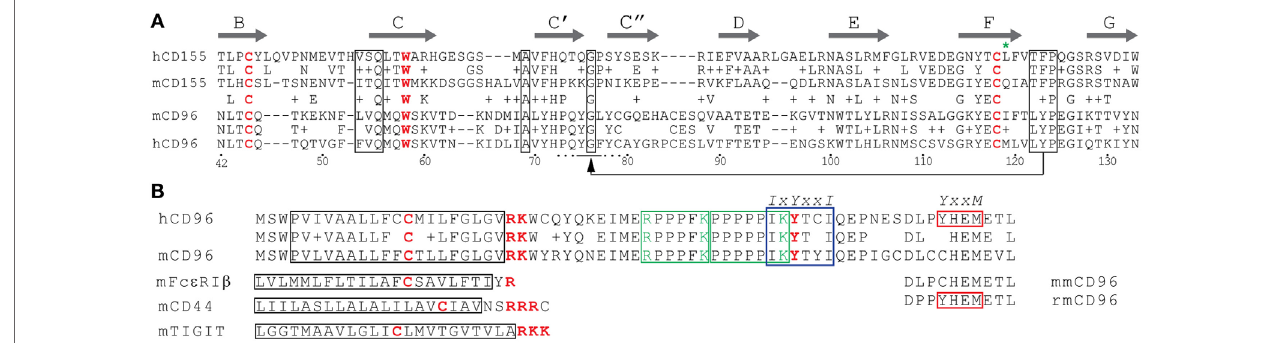
FiGURe 3 | Sequence alignments of CD96 and CD155 domains. (A) Alignment of domain 1 of human CD155 (hCD155) and mCD155 as well as human CD96 (hCD96) and mouse CD96 (mCD96). The β -strands (thick arrows) are given according to crystal data for hCD155 (33), but the A strands were not included. A + indicates amino acids with similar chemical properties. Diagnostic residues typical of IgSF members, the cysteines forming the intra-domain disulfide bridge and tryptophan residues, are shown in red. Boxed are conserved sequences among nectins, CD155, and TIGIT that are important for homodimer and heterodimer formation as discussed in the text. The arrow highlights amino acids involved in contact formation where residues of the FG loop of one binding partner contact the C ′ C ″ pocket of the other (located at the AX 6 G motif, A and G are boxed). The residues adjacent to the cysteine (green star) in the F strand face each other in the dimers. An additional alignment of mCD155 and mCD96 is superposed to highlight conserved amino acid residues among these distantly related receptors. (B) Alignment of the transmembrane (TM) and cytoplasmic domains of hCD96 and mCD96. The TM regions are boxed in black, the tandem proline-rich region in green, the ITIM motif (IXYXXI) in blue, and the YXXM motif in red, respectively. A cysteine residue located in the TM regions is highlighted in red along with the basic residues at the beginning of the cytoplasmic domain. Basic residues flanking the proline-rich motifs are marked in green and the tyrosine of the ITIM motif in red. Shown are also short corresponding amino acid sequences of mFc ε RI β , mCD44, and mTIGIT for comparison on the left side. Peptides representing these regions in mFc ε RI β , mCD44, and mCD28 bound to the SRC-related kinases LCK and LYN (34). To the right, the C-terminal CD96 residues of gray mouse lemur ( Microcebus murinus , mmCD96) and rhesus monkey (rmCD96) are aligned to demonstrate that the YxxM motif is not conserved among non-human primates. Alignments of the domain 1 and the TM/cytoplasmic domains were done using the NCBI blastp suite applying standard settings, TM regions were predicted by the TMHMM Server v.